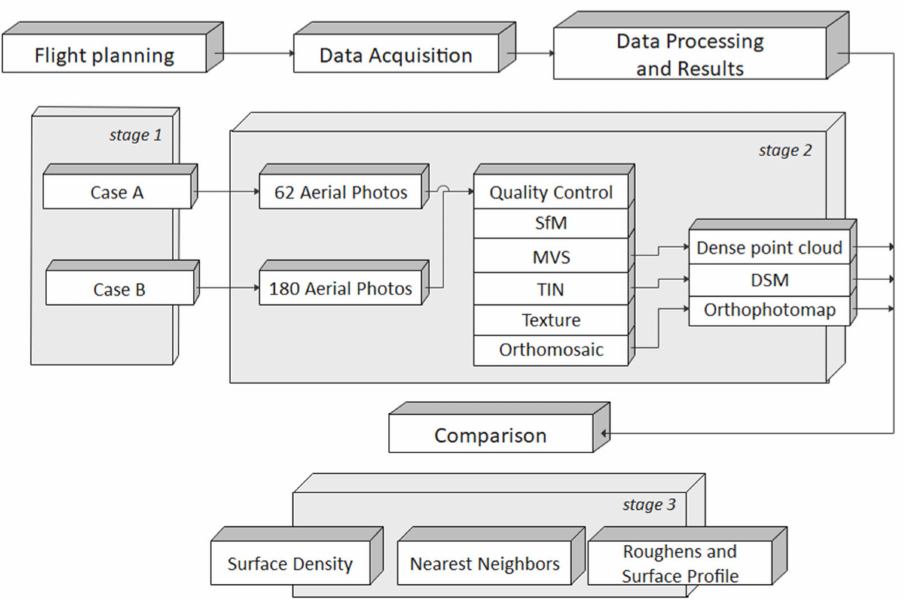
Figure 1. Methodology flowchart consisted of three main stages.